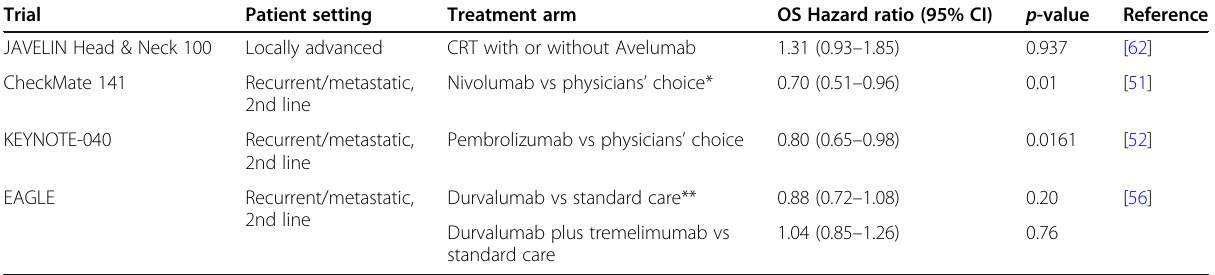
Table 3 The results of phase 3 trials evaluating the efficacy of immune checkpoint inhibitors to SCCHN other than KEYNOTE-048